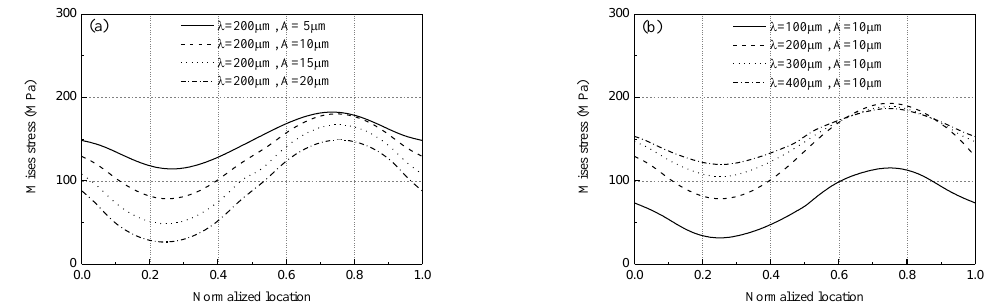
Figure 10. Mises stress along the length of the surface of CMCs coatings with different ( a ) amplitude; ( b ) wavelength.